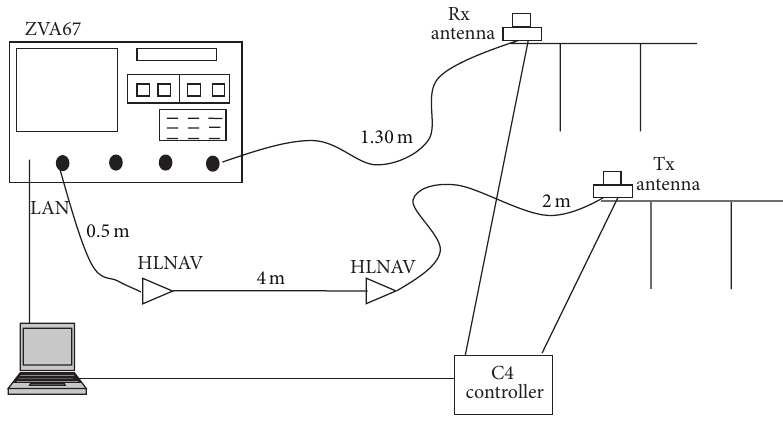
Figure 2: Scheme of the channel